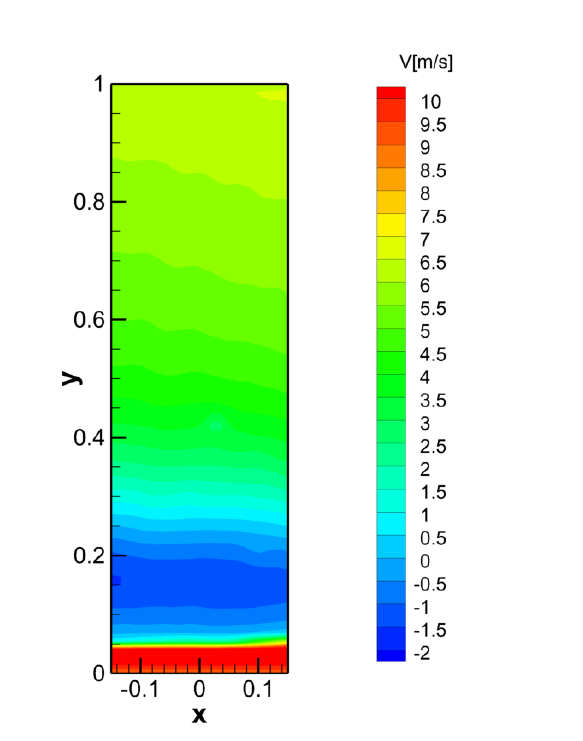
Fig. 4. Streamwise mean velocity component distribution.